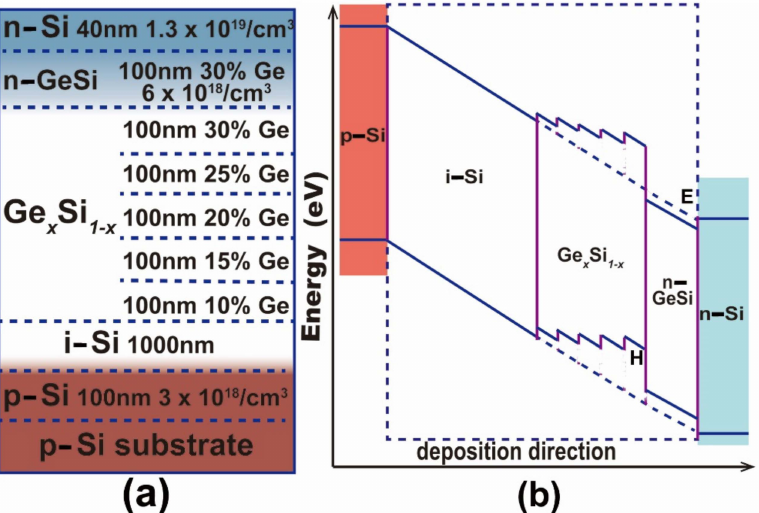
Figure 1. Schematic layer structure and energy band diagram. ( a ) The layer structure grown on the micro-hole patterned and the flat Si(001) substrates, ( b ) the energy band diagram of the